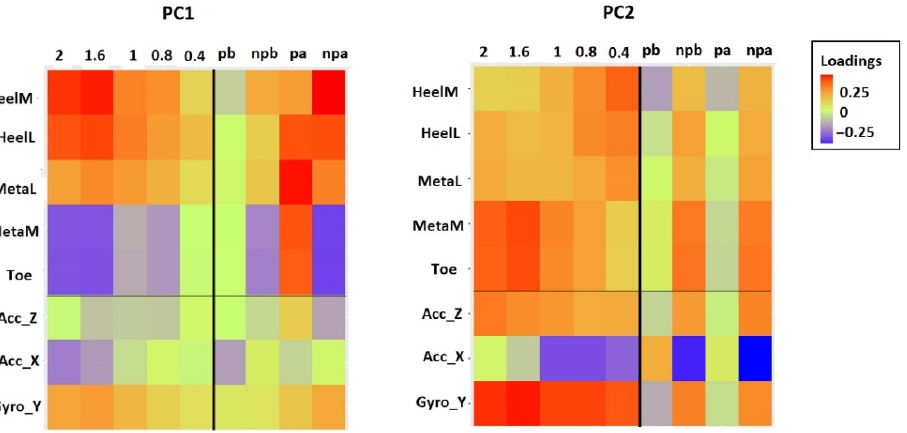
Figure 11. Weighting coefficients of the PC 1 and PC 2 for all groups. Coefficients are plotted on a color-coded scale.